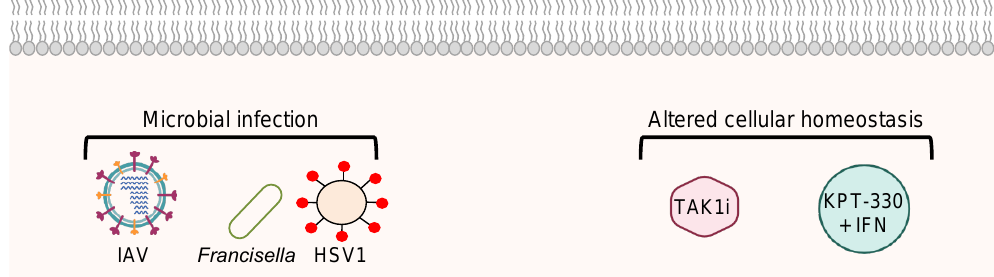
duce necrosis in response to a mutant form of MCMV expressing a tetra-alanine RHIM